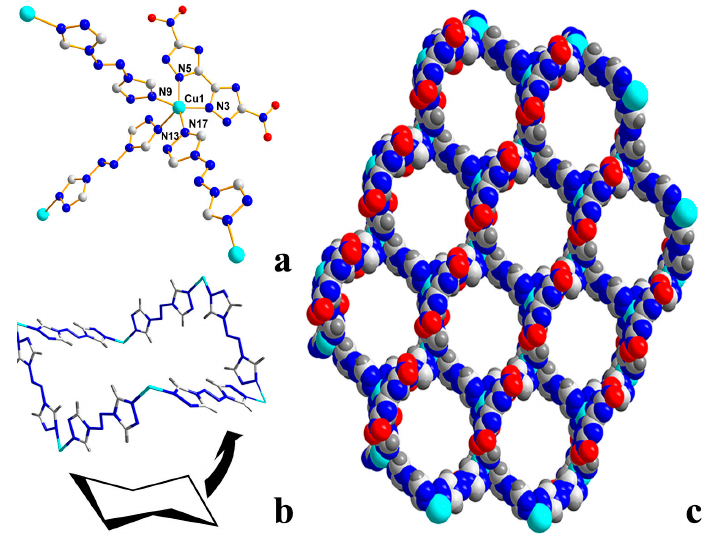
Figure 1. ( a ) Coordination environment of Cu(II) in 1 ; ( b ) 2D chain in 1 ; ( c ) 3D network in 1 by π - π interactions.